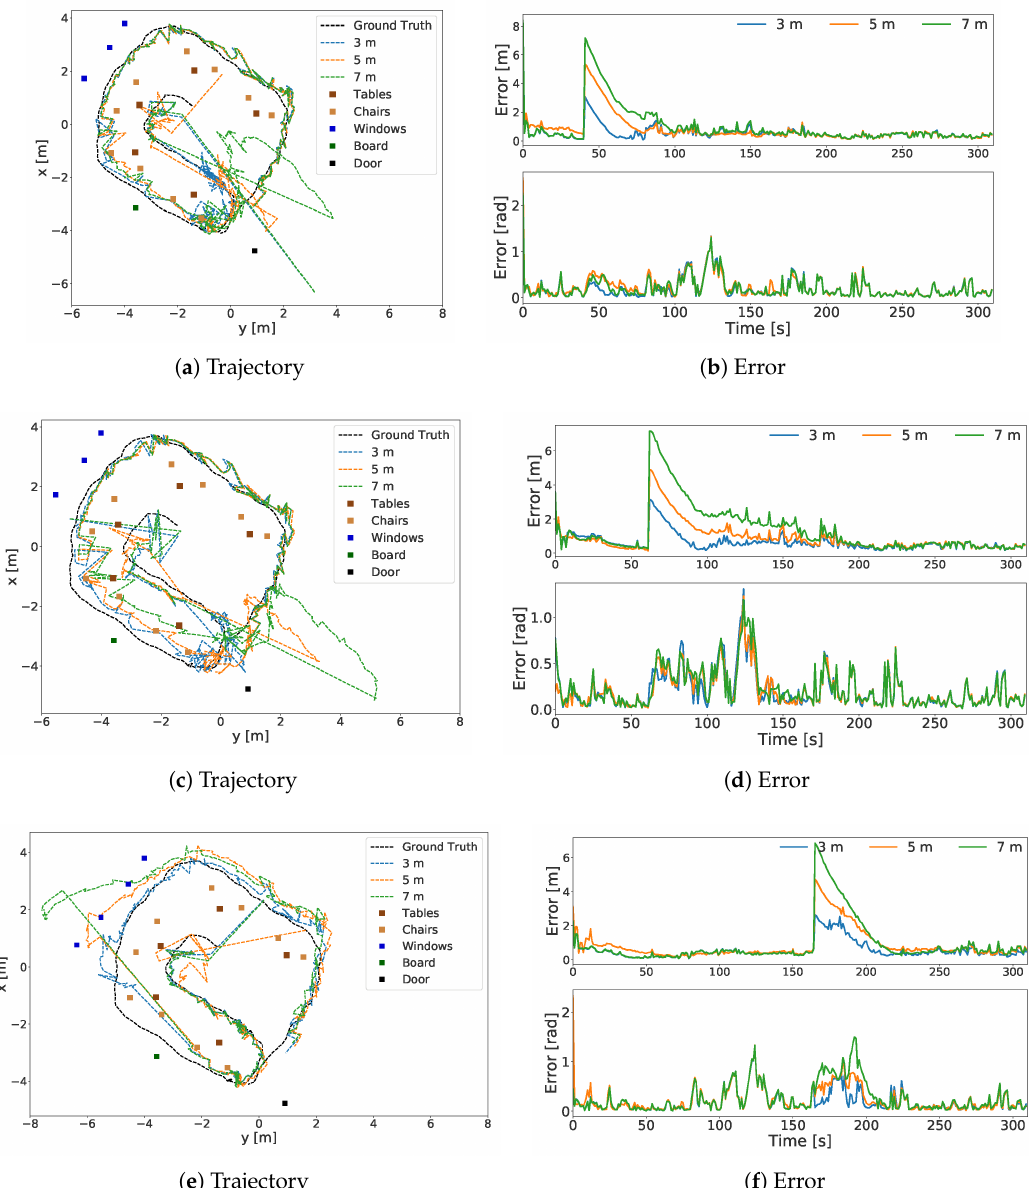
Figure 7. Sensor error: jump. Sensor models were exposed to 3 m, 5 m and 7 m jumps at three different timesteps. Subfigures ( a , b ) belong to the first jump. Subfigures ( c , d ) show the second jump. Subfigures ( e , f ) show the third